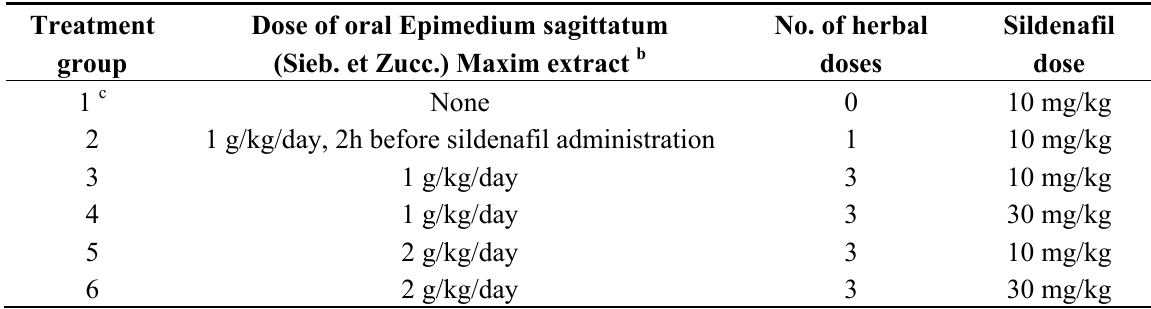
Table 2. The dosage regimens of Epimedium sagittatum (Sieb. et Zucc.) Maxim extract and sildenafil administration a .